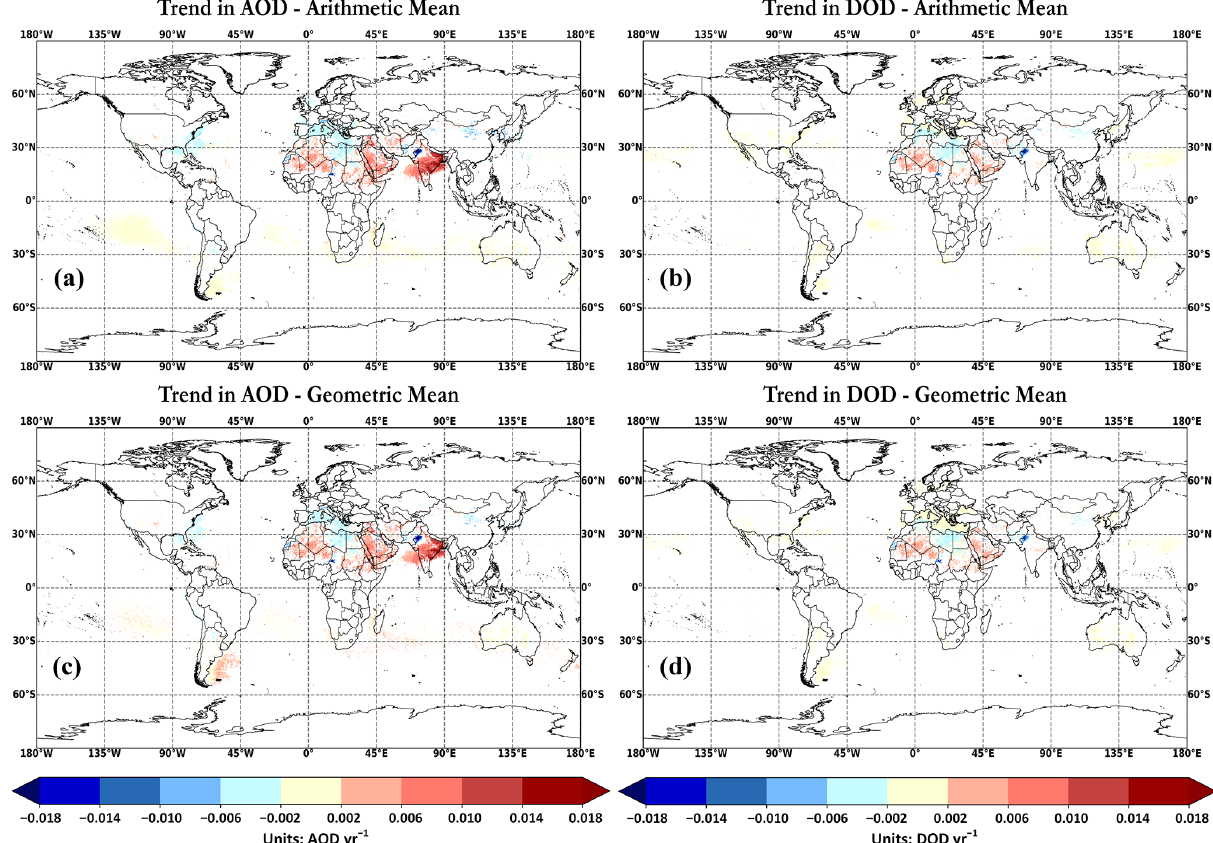
Figure 2. Global maps of temporal trends (statistically significant at 95% confidence level) at 1 ◦ × 1 ◦ spatial resolution calculated from the deseasonalized AOD (a) and (c) and DOD (b) as well as (d) monthly values during 2003–2017. The upper panels, (a) and (b) , show the arithmetic-based trends, while panels (c) and (d) indicate the geometric-based trends. For the pixels with (1) non-significant trends, (2) the temporal criteria are not met and (3) non-available data are colored white (blank) in each map of the trend analysis. Neutral trends, ranging between − 0 . 002 and 0.002DODyr − 1 , are colored light yellow (or cream) (the central color of the color bar). Figure S3a, b and S4 present the differences between the aforementioned colors at fine and coarse spatial resolution as well as for the seasonal trends, respectively. Based on those figures, the pixels with no available data are colored gray, while those that fail to meet the availability criteria are colored